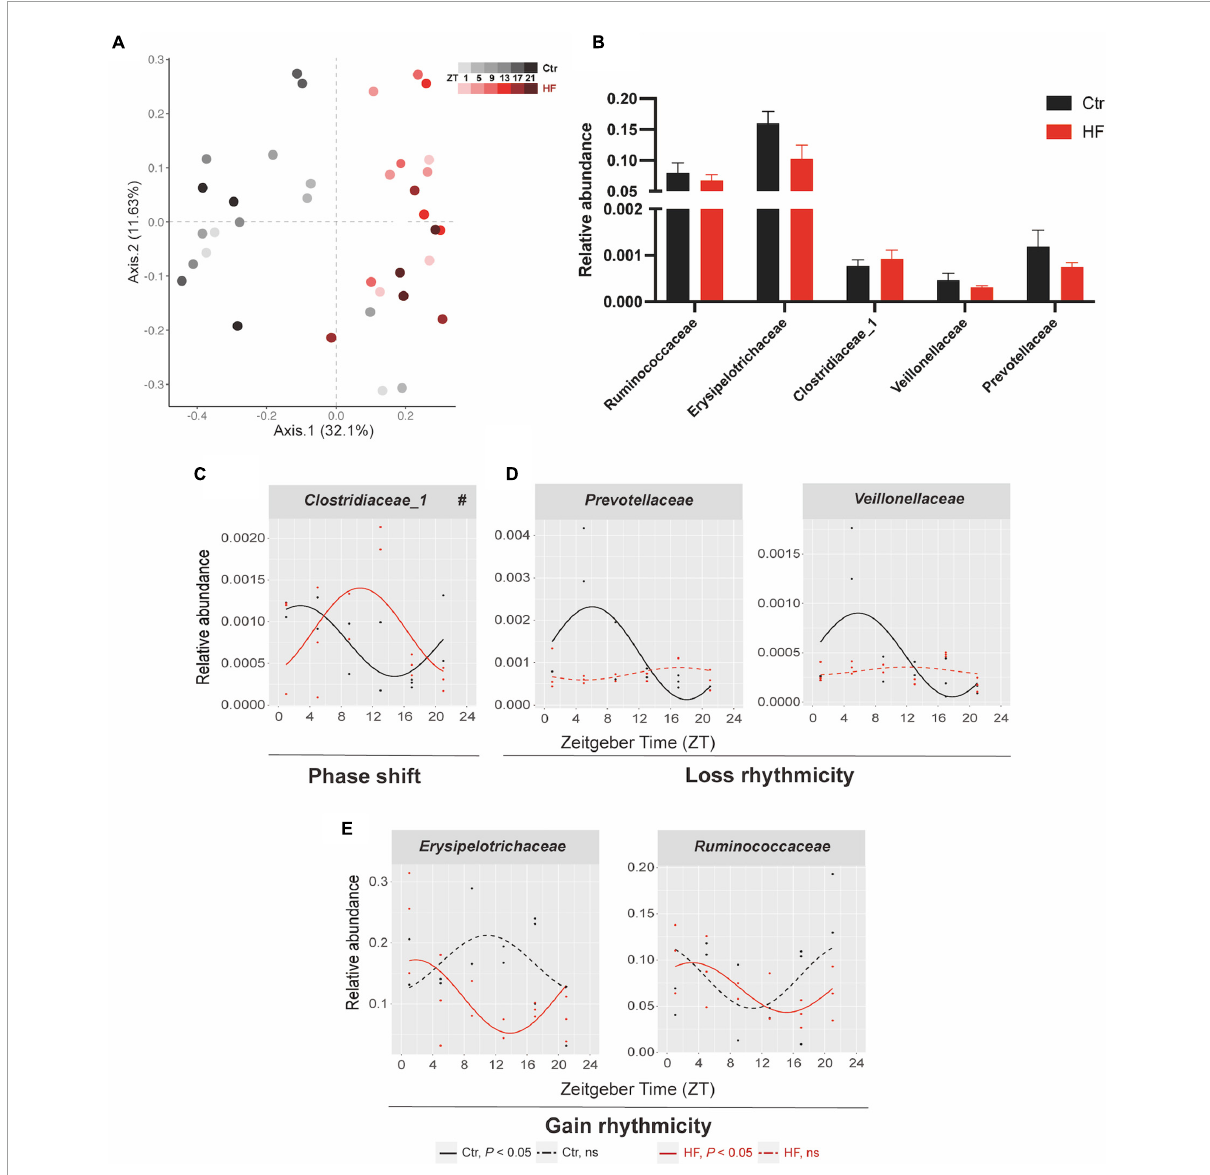
FIGURE4 Diurnal rhythm of gut microbiota was altered in a diverse manner in HF-treated gestational mice. Mice were fed with a standard chow diet, or a high-fat diet prior to pregnancy for 5 weeks, and throughout pregnancy. The morning of vaginal plug confirmed the pregnancy and was considered E0.5. On E18.5, the pregnant mice were killed at 4-h intervals over 24 h. (A) Bray–Curtis PCoA. Shading represents different time points as indicated. (B) The relative abundance and (C–E) the diurnal patterns of microbiota. Significant rhythms ( P < 0.05) are denoted by the continuous line, and non-significant rhythms are denoted by the dotted line. The dots mark individual measurements in each zeitgeber time (ZT), and line represents cosinor regression fit. Rhythmic pattern of genes with significant differences in phase (#) derived from CircaCompare ( n = 2–3/time point). Data of bar chart are expressed as means ± S.E.M. ( n = 12/group) using Student’s t -test. Ctr, standard chow diet-fed pregnant mice; HF, high-fat diet-fed pregnant